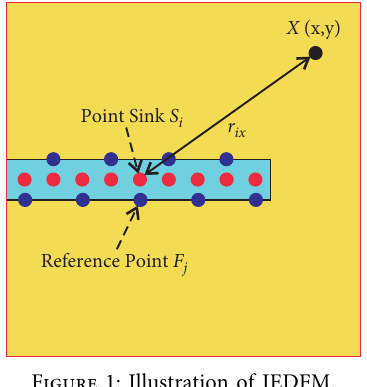
Figure 1: Illustration of